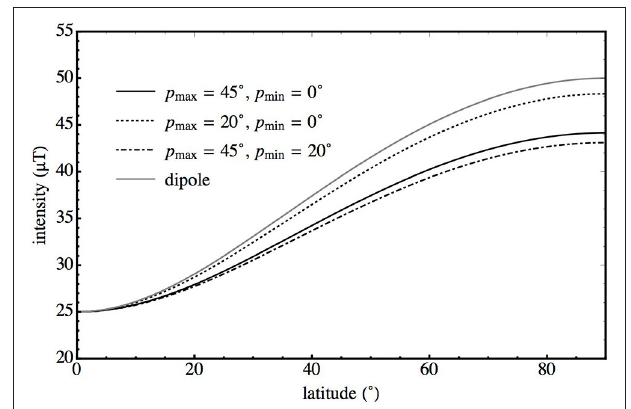
FIGURE 2 | B TAF (Equation4) calculated for four models as a function of latitude using a latitudinal bin size of 10 ◦ : 1) p max = 45 ◦ , p min = 0 ◦ , 2) p max = 20 ◦ , p min = 0 ◦ and 3) p max = 45 ◦ , p min = 20 ◦ . Additionally the standard dipole model (Equation1) is also calculated. In all four models the equatorial field was set to 25 µ T, i.e., B TAF eq = B D eq = 25 µ